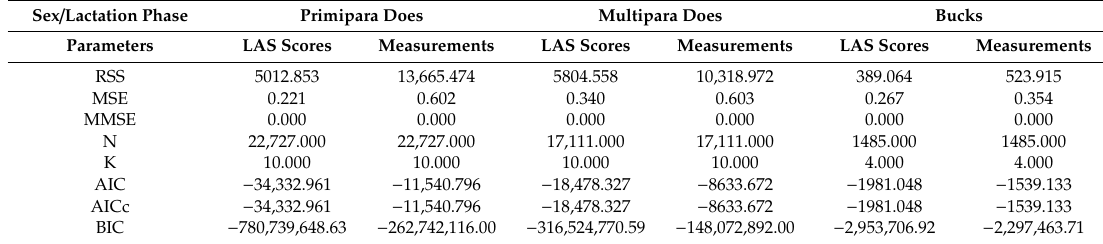
Table 8. Summary of the measures for model fit using the mean square residual or error and minimum square residual or error (MSE and MMSE), explanatory variability power using the Akaike information criterion (AIC) and corrected Akaike information criterion (AICc) and predictive power using the Bayesian information criterion for the two linear regression models comprising linear appraisal traits as opposed to Murciano-Granadina zoometric traditional assessment in does and